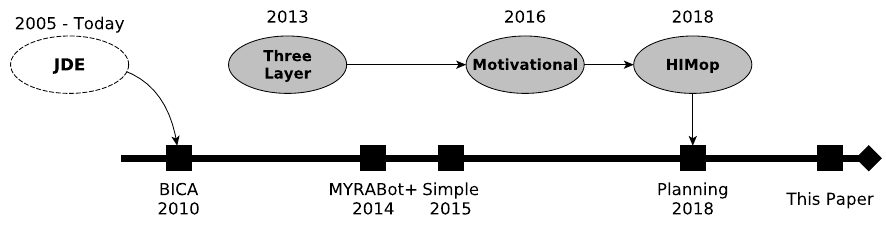
Figure 1. Historical evolution of the Gentlebots robot